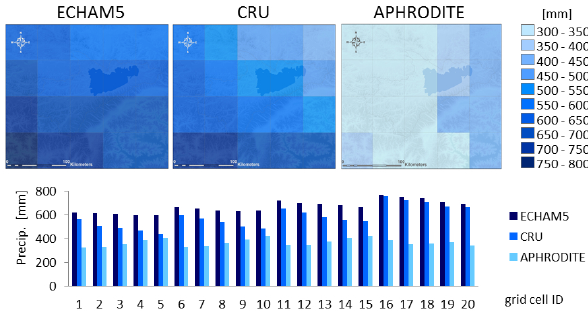
Fig. 5. Comparison of annual mean precipitation data of ECHAM5, CRU and APHRODITE for the period 1981–2004.